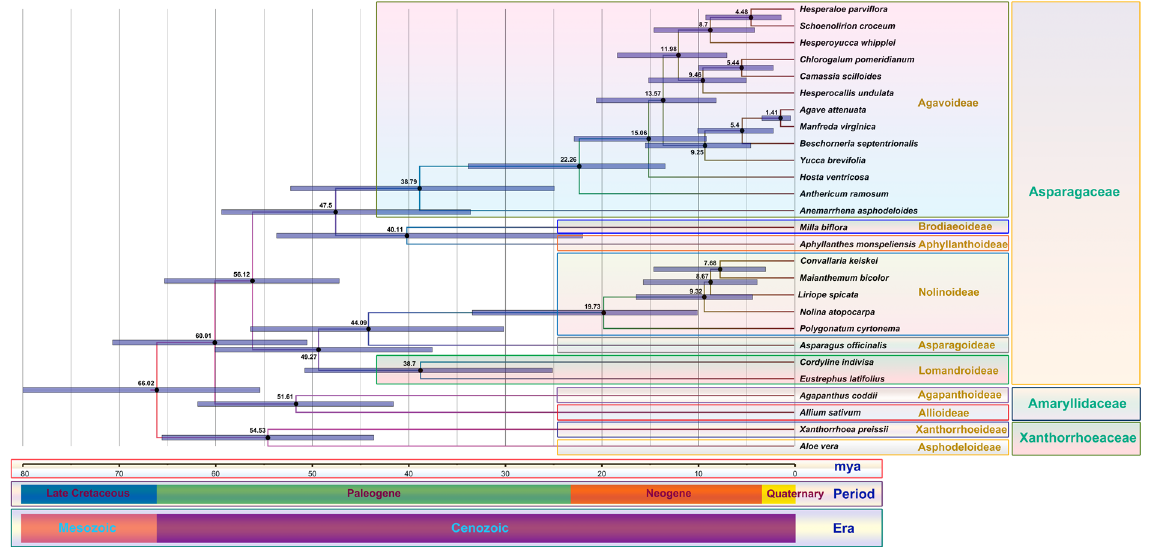
Figure 6. Molecular clock based on 68 protein-coding genes of 27 Asparagales chloroplast genomes using BEAST. Mean age estimates (in millions of years) are shown along the branches. Grey bars represent the 95% posterior density credibility intervals for node ages.